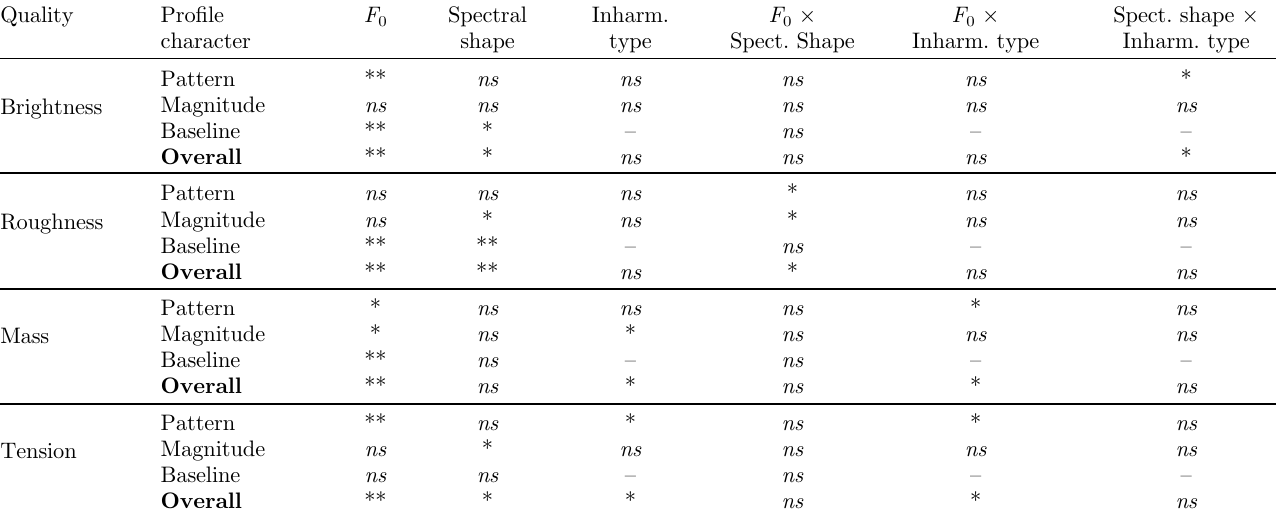
Table 4. Summary of all signi fi cant main effects and interactions from acoustic parameters on predicting the ratings of the four examined qualities. * p < .05, ** p < .001, ns , non signi fi cant.